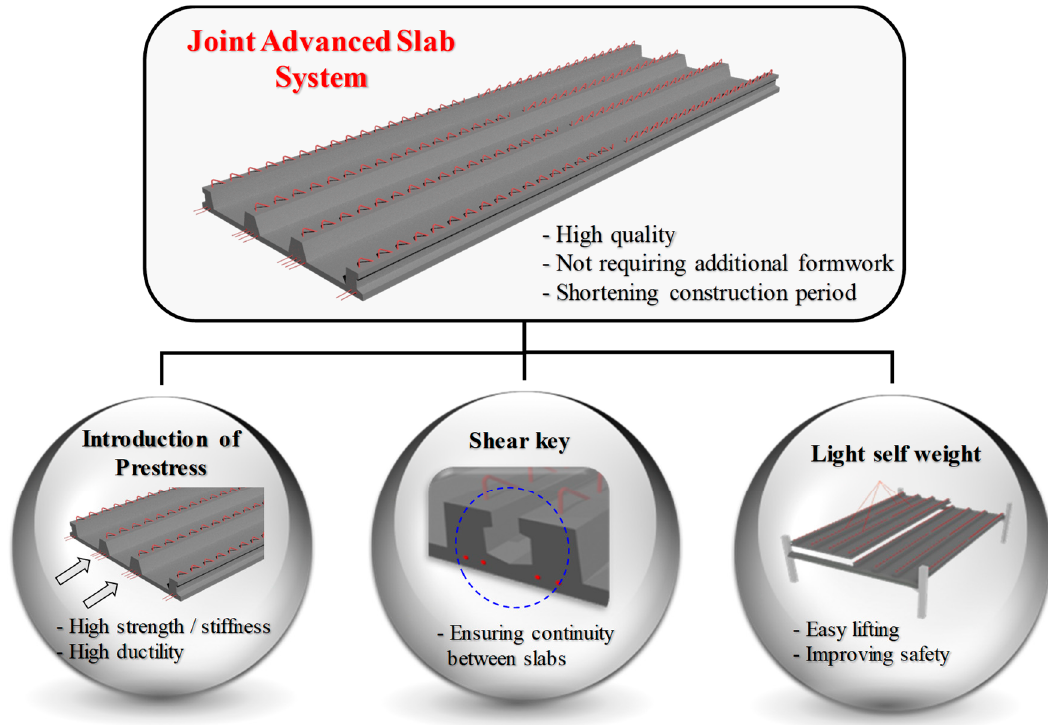
Figure 1. Characteristics of the joint advanced slab (JAS).